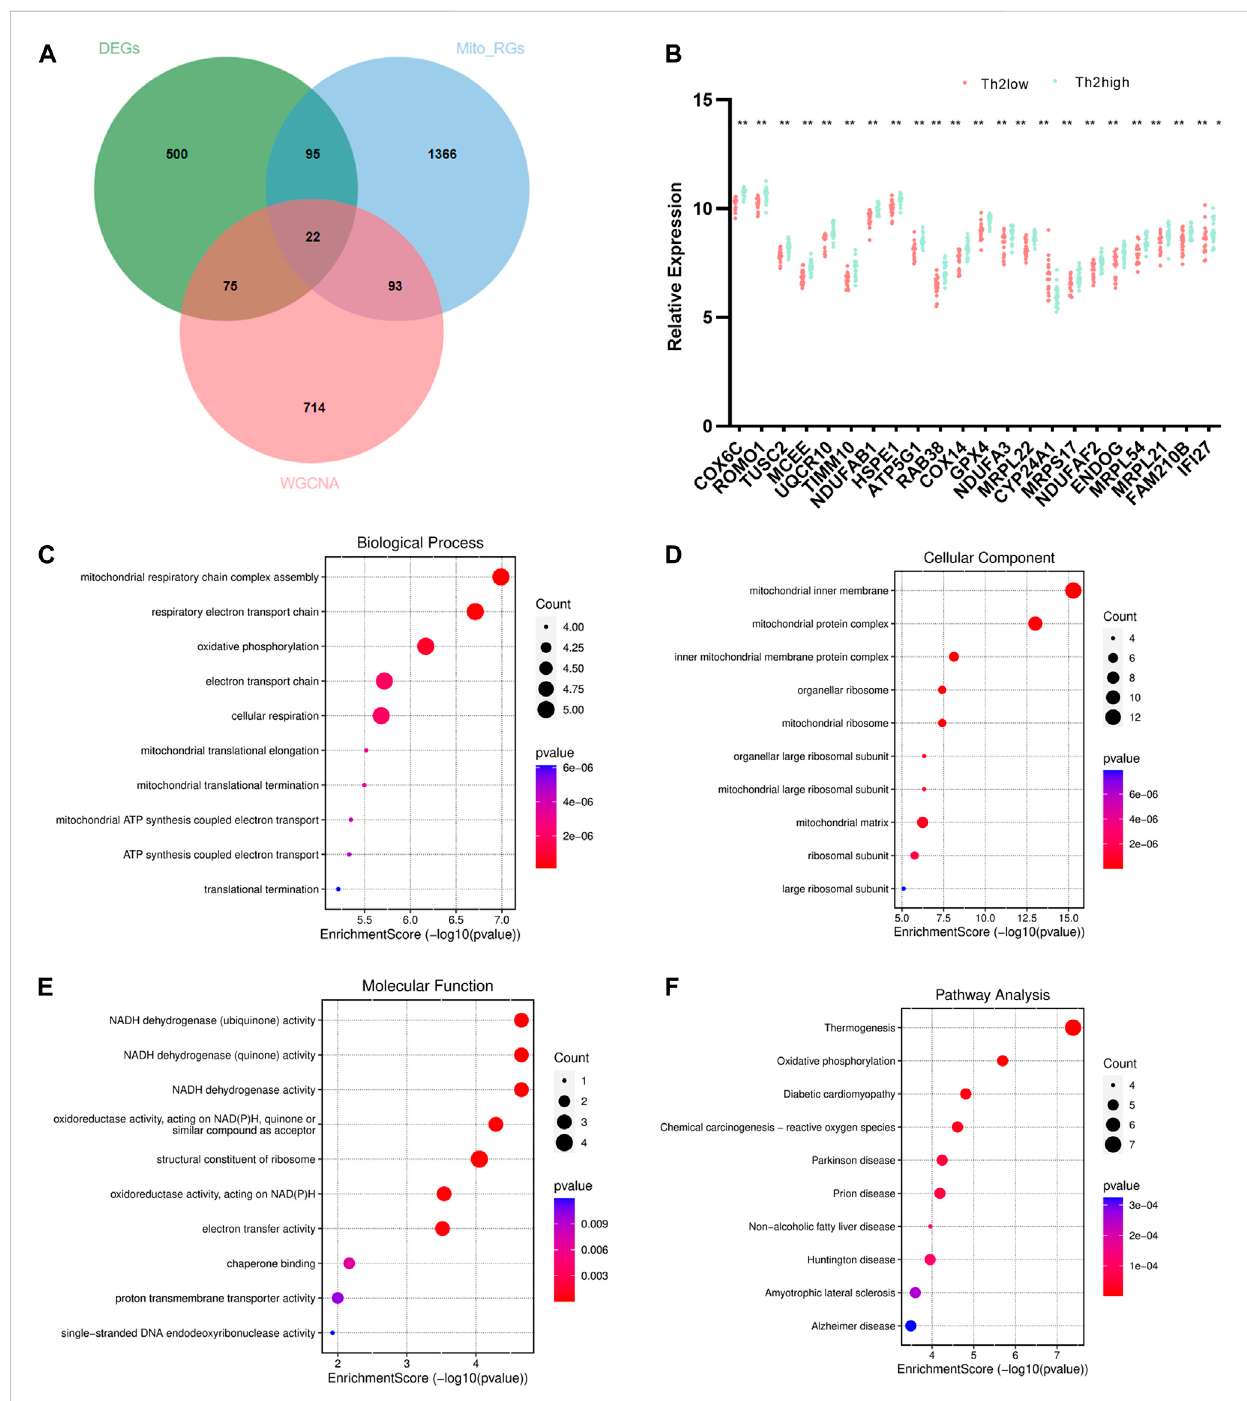
Figure 6. These genes were also poorly expressed in the T2-low group with Wilcoxon test, consistent with the results of